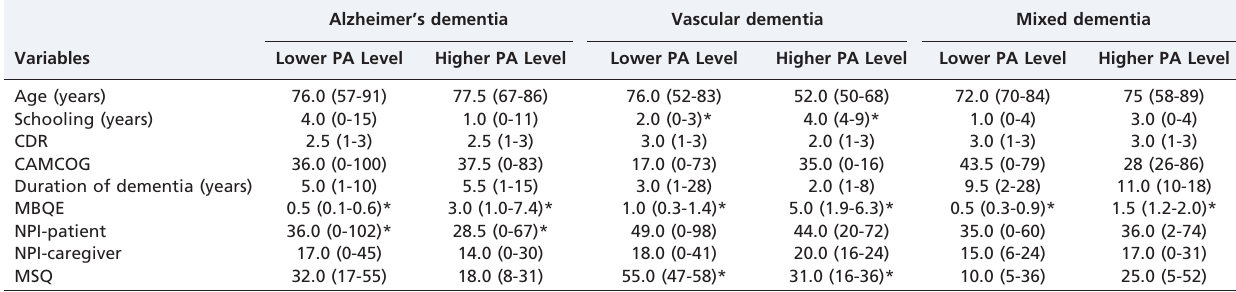
Table 1 - Clinical and demographic characteristics (medians and confidence intervals) of patients with Alzheimer’s, vascular and mixed dementia, separated into higher and lower levels of physical